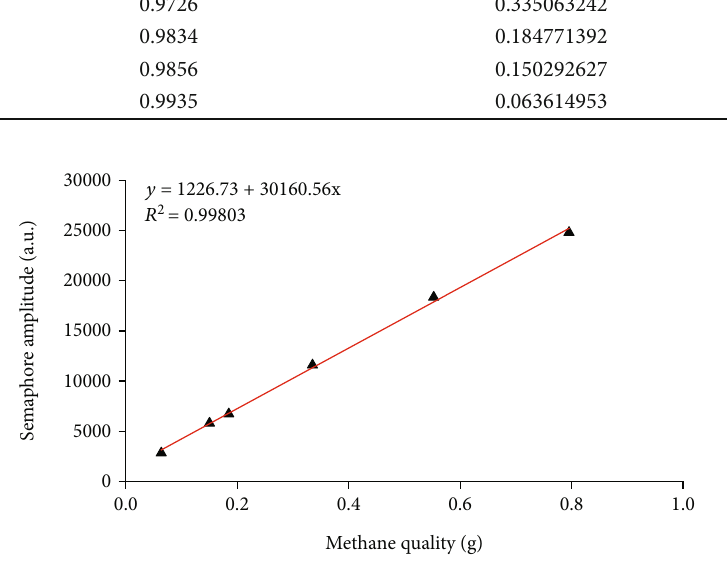
Figure 4: Calibration of methane gas quality and signal amplitude.